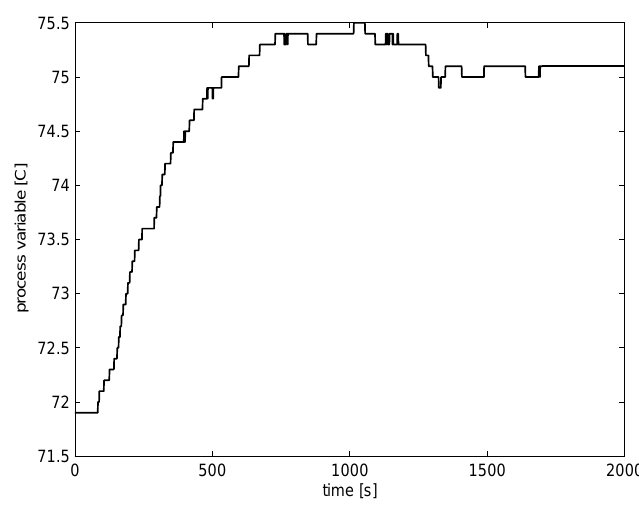
Figure 3. Initial set-point step response in the temperature control loop.